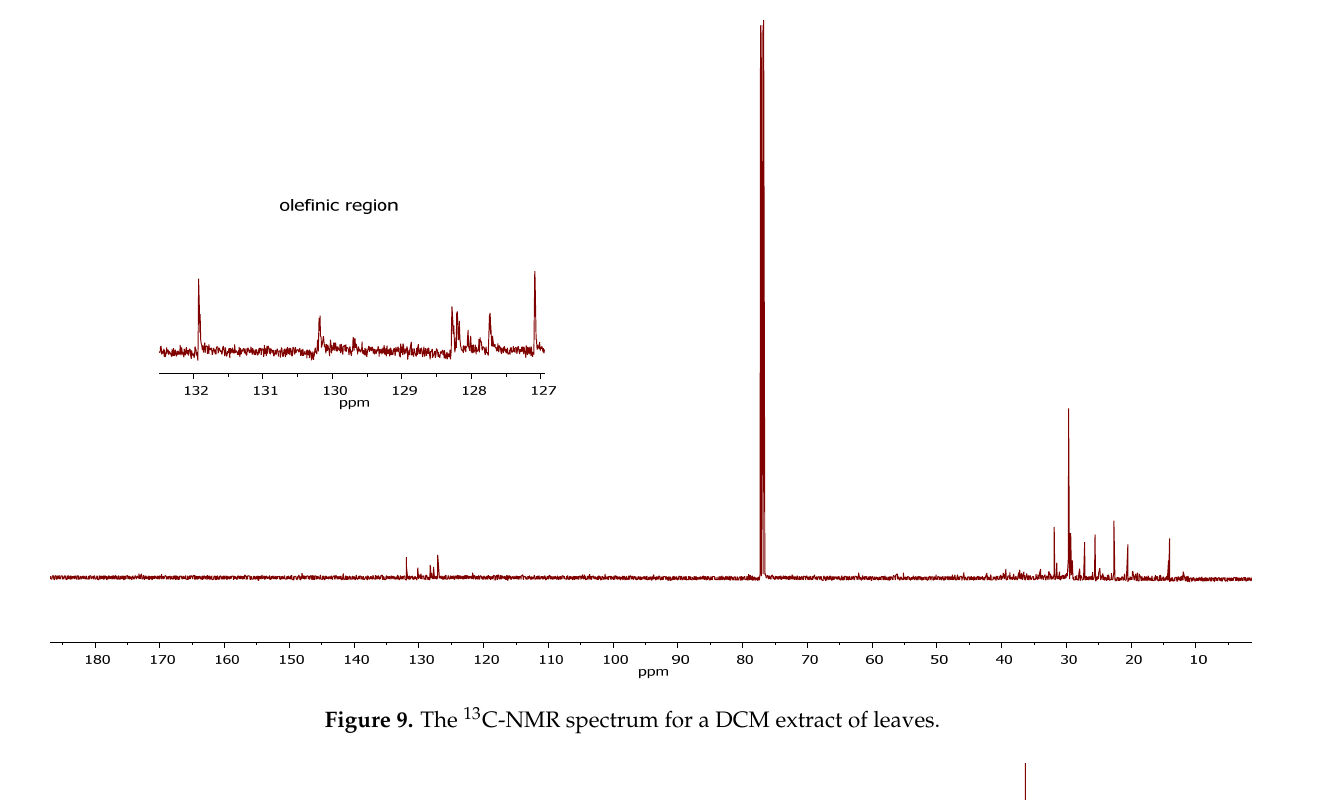
Figure 9. The 13 C-NMR spectrum for a DCM extract of leaves.